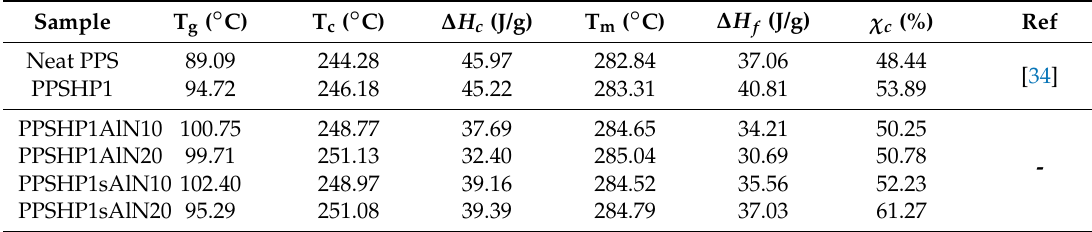
Table 4. DSC characteristic thermal data of the PPS/MWCNTs/AlN